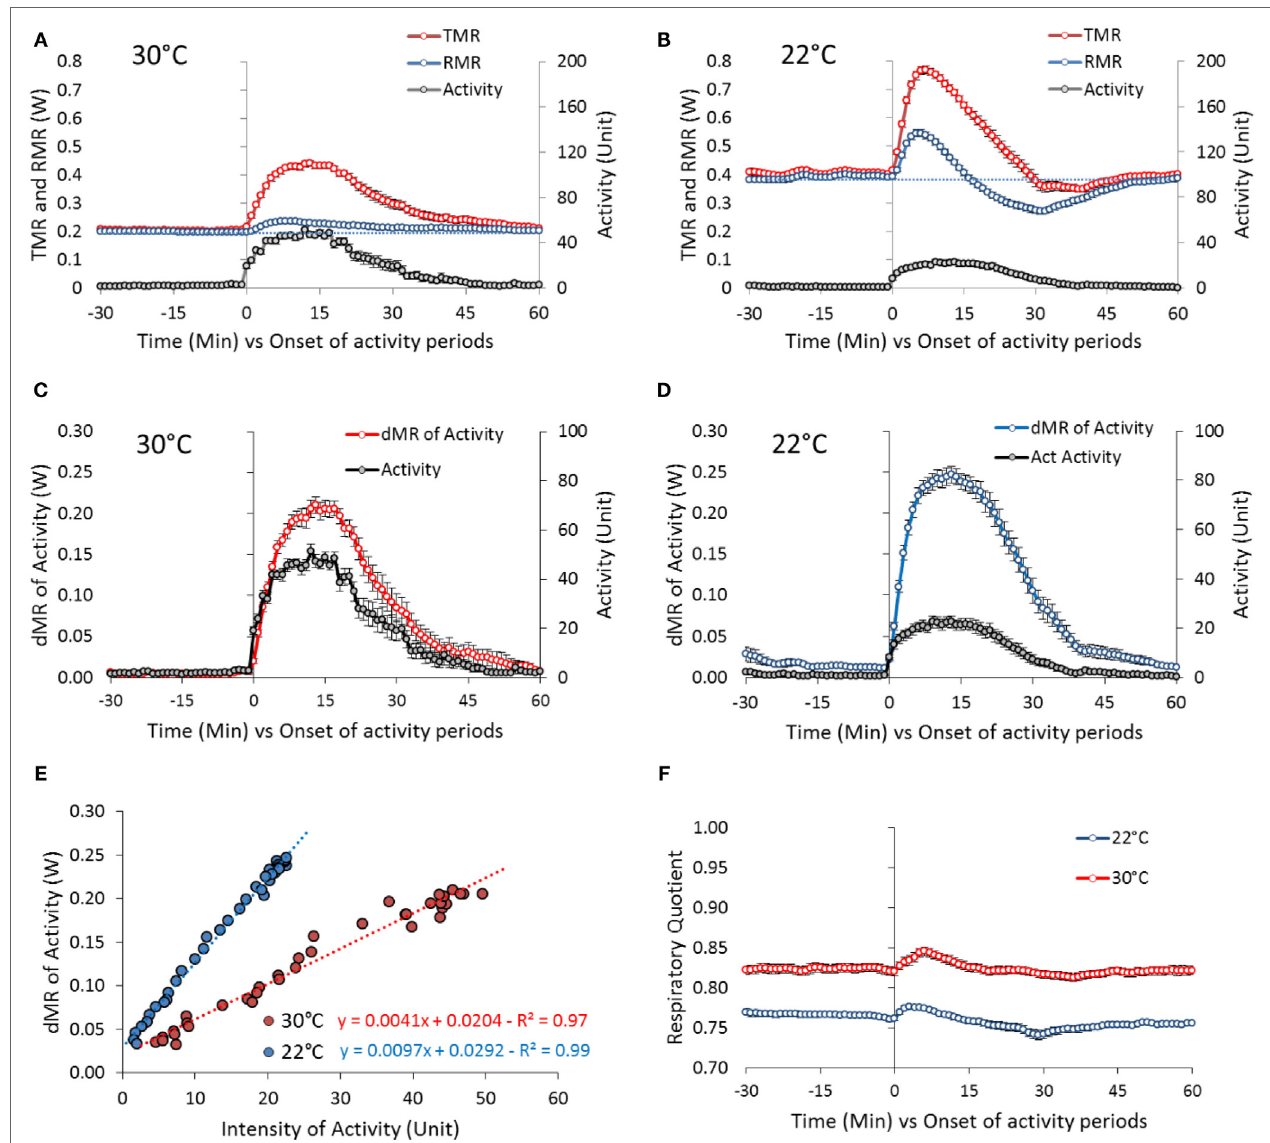
FigUre 6 | activity-induced changes in TMr and rMr in mice housed at 30°c (31 periods of activity from 11 mice) and 22°c (42 periods of activity from 10 mice) . The periods of activity have been chosen as periods of well differentiated bouts of activity, preceded and followed by at least 1 h of quite complete rest that occurred during the overnight fast and the morning before the test-meal. The first 5 h of recording after the mice were housed in the metabolic chamber (18:00–23:00 hours) were discarded to focus on the response of mice in the post-absorptive state and adapted to the temperature in the cage (see Figure 3 ). (a,B) Absolute changes in TMR and RMR at 30 and 22°C. Blue dashed line: extrapolation of pre-activity RMR values. (c,D) Changes in δ MR ( δ MR = TMR − RMR and reflects the true direct activity cost). (e) Correlation between activity and δ MR changes at 30 and 22°C. (F) Absolute changes in